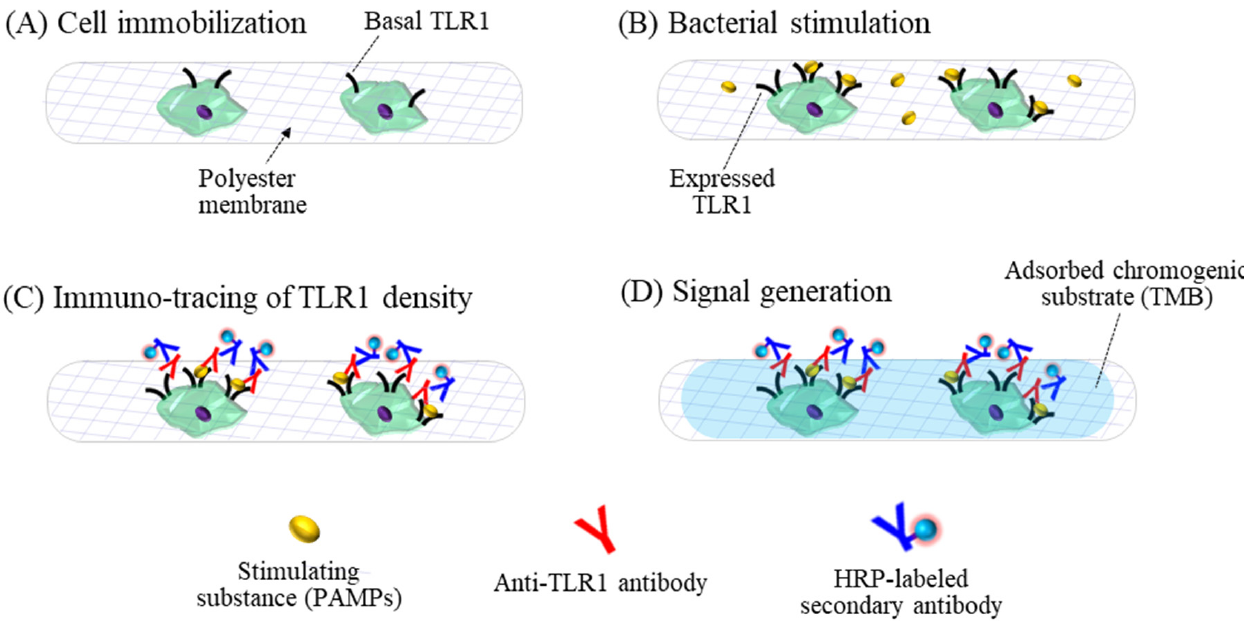
Figure 2. The analytical concept of the membrane filter-assisted mammalian cell-based immunoassay. ( A ) Mammalian cells were immobilized on the porous membrane treated with ethanol and ( B ) tested for the response to external stimuli using bacterial lysate and live bacteria. ( C ) The expressed TLR1 was applied as a biosensing marker for the inflammatory responses, recognized using the anti-TLR1 antibody and the enzyme-labeled secondary antibody. ( D ) The signals were generated by the chromogenic substrate absorbed by enzyme reactions on the membrane scaffold.